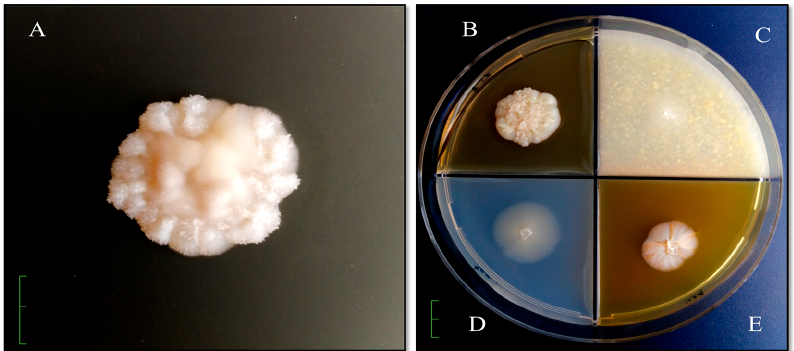
Figure 1. Macroscopic appearance of cultured colony of C. parapsilosis № 398.2 on Sabouraud agar ( A ), potato agar ( B ), corn agar ( C ), Chapek's medium ( D ) and honey agar ( E ), 32 ° С , 6 days, bar = 1 potato agar ( B ), corn agar ( C ), Chapek’s medium ( D ) and honey agar ( E ), 32 ◦ C, 6 days, bar = 1 cm.